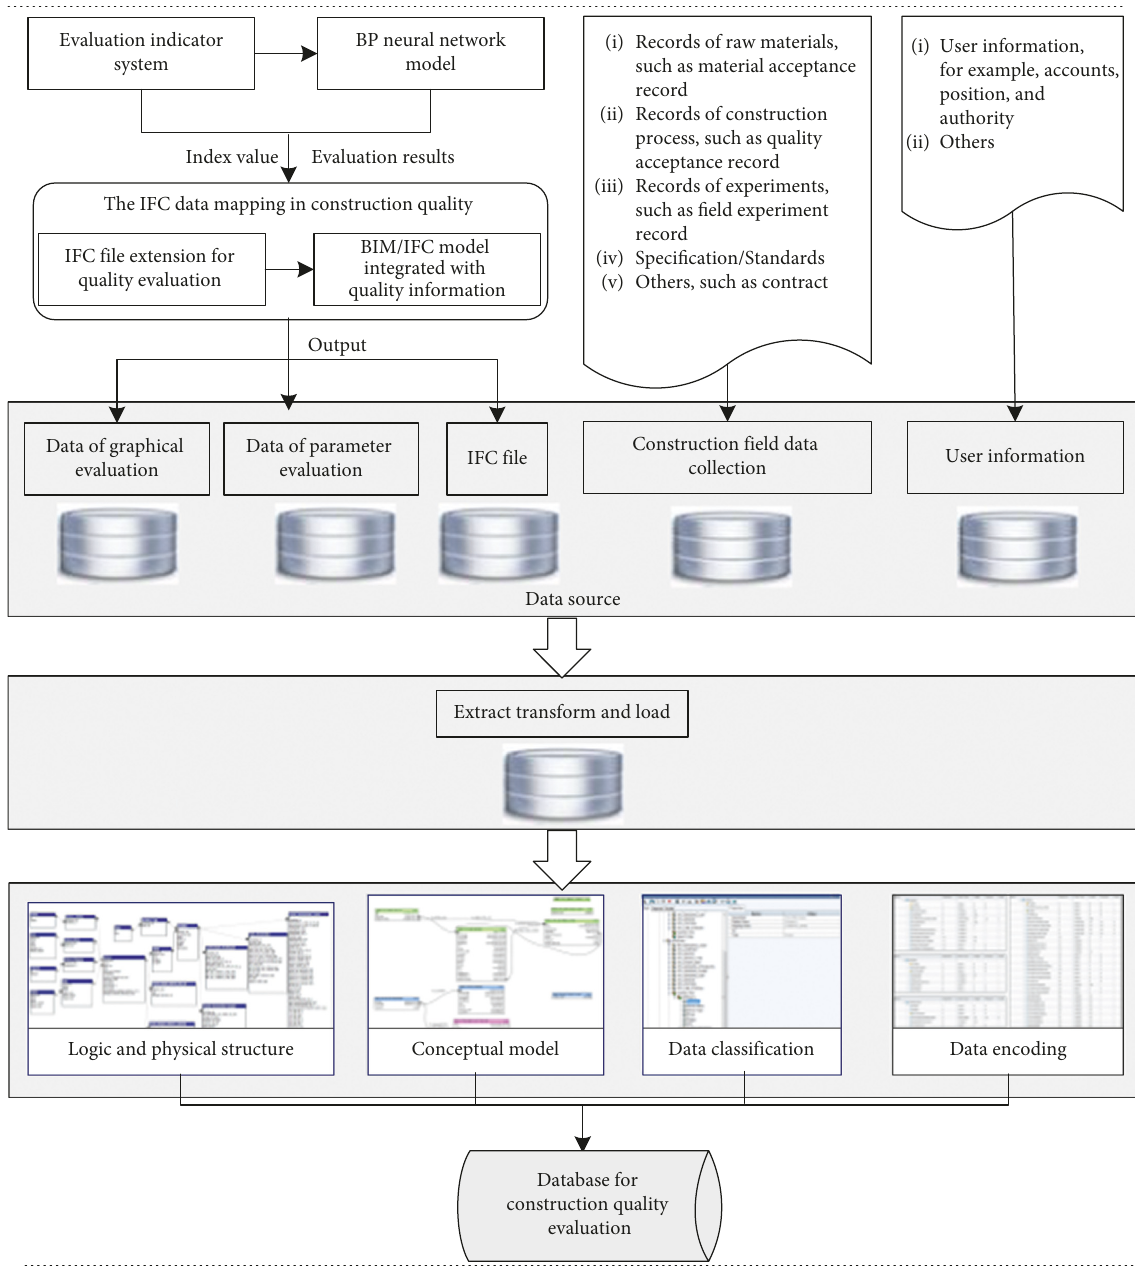
Figure 1: Method